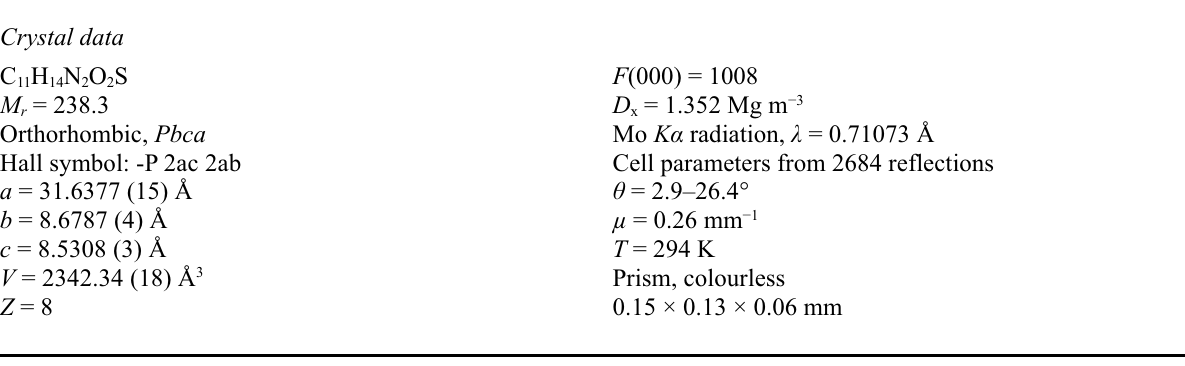
View of the crystal packing of the title compound projected down the b axis. Intermolecular hydrogen bonds (N1– H1···O1) form one-dimensional chains along c axis. The hydrogen bonds are shown as dotted lines.